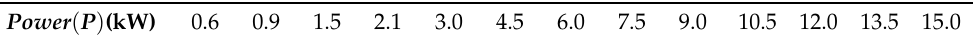
Table 2. List of power controlled static measurements for the calibration of the model.